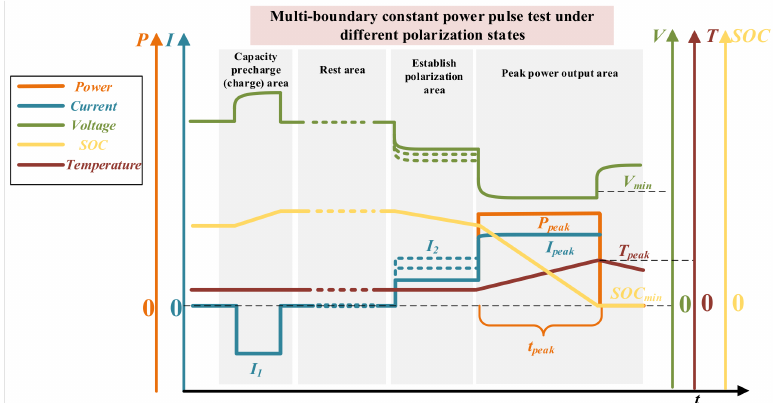
Figure 8. Constant power pulse test under different polarization